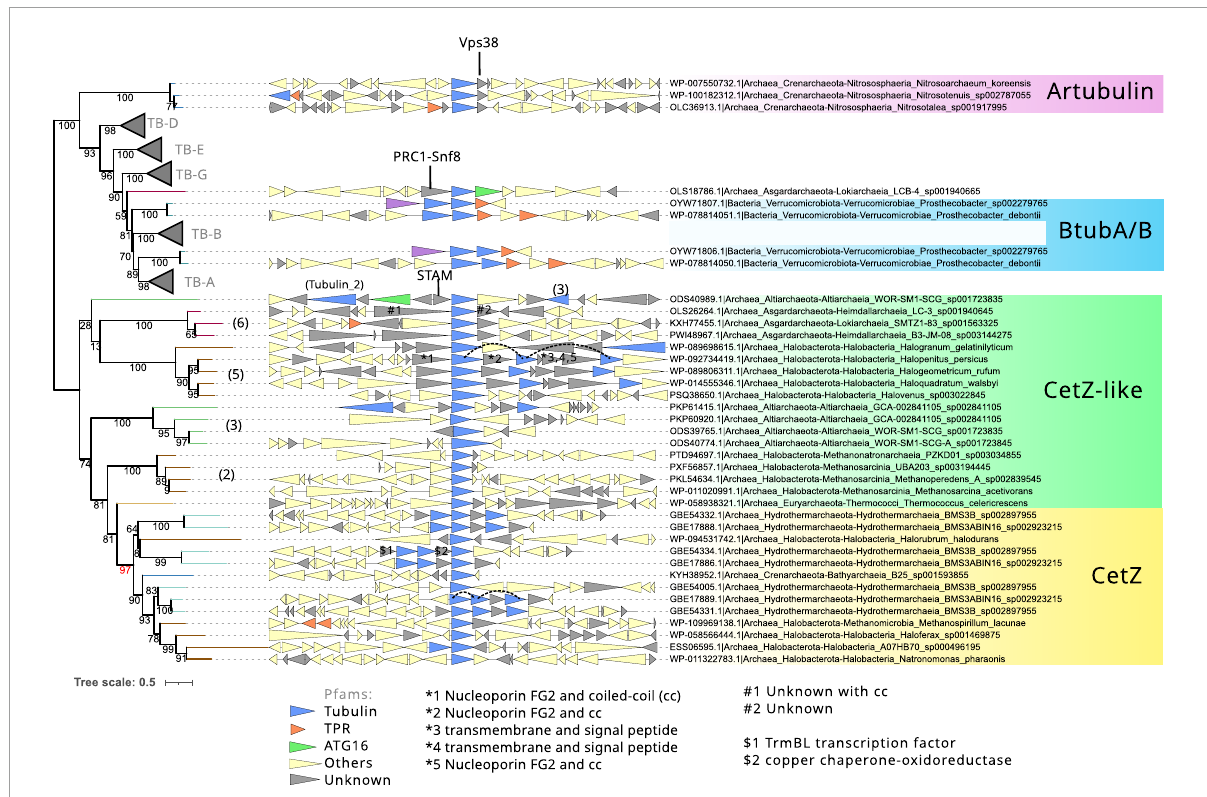
FIGURE6 Phylogeny and genome context of the prokaryotic tubulin and CetZ-related sequences. The tree was rooted at the mid-point. The dataset for the phylogeny was selected manually, applying a gap trimming of 10%, resulting in a final MSA of 81 sequences and 485 positions. The tree was built using IQ-TREE, automatic model selection (LG + R5), and ultrafast bootstrap (UFBoot2). The number between parenthesis indicates the phylogenetic groups in Figure 4 . Red bootstrap denotes the supported node defining the canonical CetZ proteins. Genes are colored according to the presence of Pfam domains, and genes without recognizable domains are colored in gray. Some of these latter were annotated with HHPred (indicated with #, *, $, and arrows). Discontinuous lines in the genome context panel show copies of the same CetZ(–like) that were omitted in this